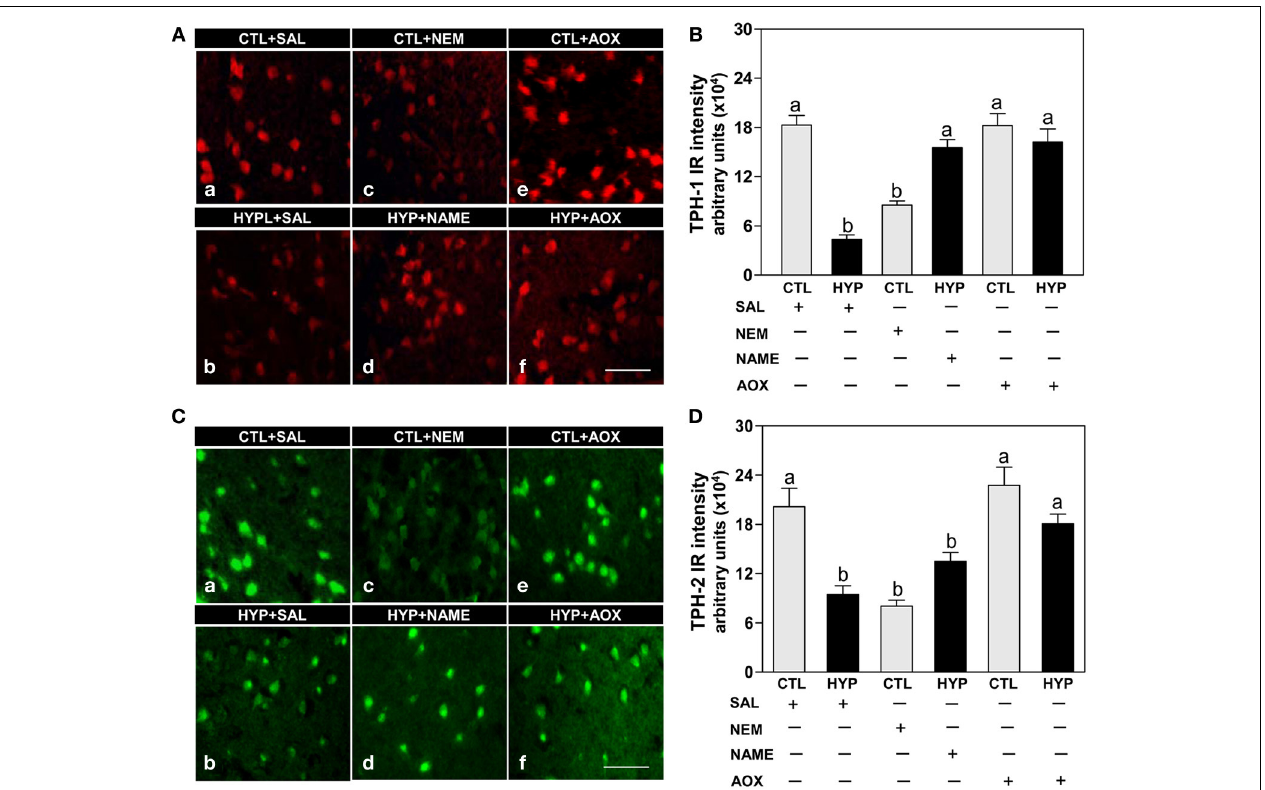
FIGURE 1 | Interactive effects of hypoxia and pharmacological agents that modulate generation of reactive oxygen and nitrogen species (ROS and RNS) on expression of TPHs proteins in croaker hypothalamic neurons assessed by immunohistochemistry. Effects of hypoxia (dissolved oxygen, DO: 1.7mg/L for 4 weeks; note: here and in subsequent figures exposure duration only refers to period fish were exposed to target DO; fish were previously exposed to declining DO for additional 2-day adjustment period) exposure and pharmacological treatments with N -ethylmaleimide (NEM, a chemical which covalently modifies sulfhydryl groups in the reactive center of enzymes), N ω -nitro-L-arginine methyl ester (NAME, an inhibitor of nitric oxide synthase) and vitamin E (an antioxidant, AOX) on